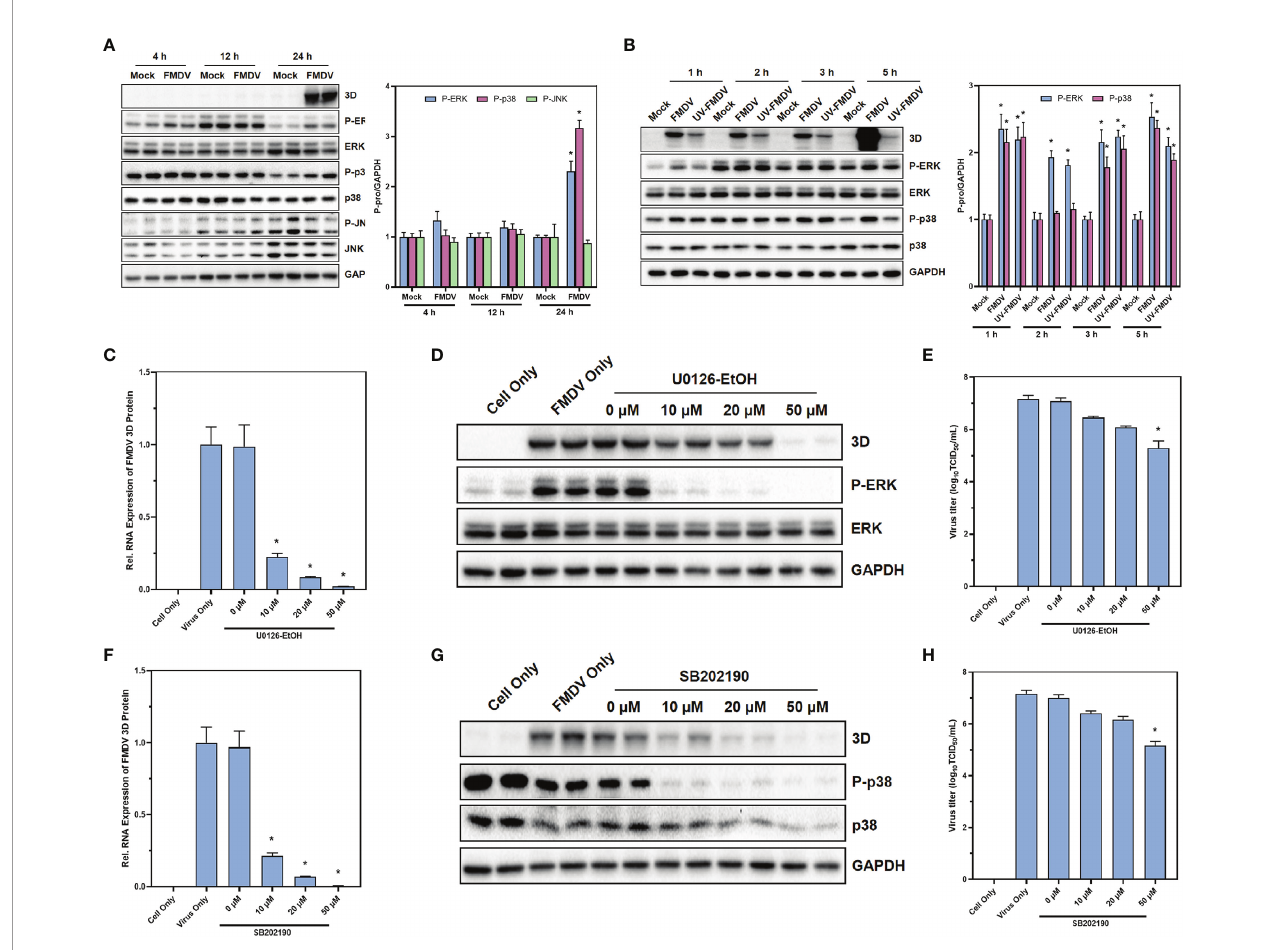
FIGURE 4 | MAPK signaling pathway was activated under the infection of FMDV with reliance on viral replication. The protein expression of the marker proteins in MAPK signaling pathway after the infection of FMDV (A) or UV-treated FMDV (B) was con fi rmed by Western blot. The effects of MAPK/ERK signaling pathway inhibitor U0126-EtOH-EtOH on RNA levels (C) , protein levels (D) , and infectious FMDV virus titers (E) and the effects of MAPK/p38 signaling pathway inhibitor SB202190 on RNA levels (F) , protein levels (G) , and infectious FMDV virus titers (H) . The intensity of pERK, p38, and p-JNK relative to GAPDH was measured by ImageLab software. GAPDH was served as the internal reference to normalize data. Three independent replicates were conducted for each sample. Data are expressed as the means ± SE (n = 3). * P < 0.01